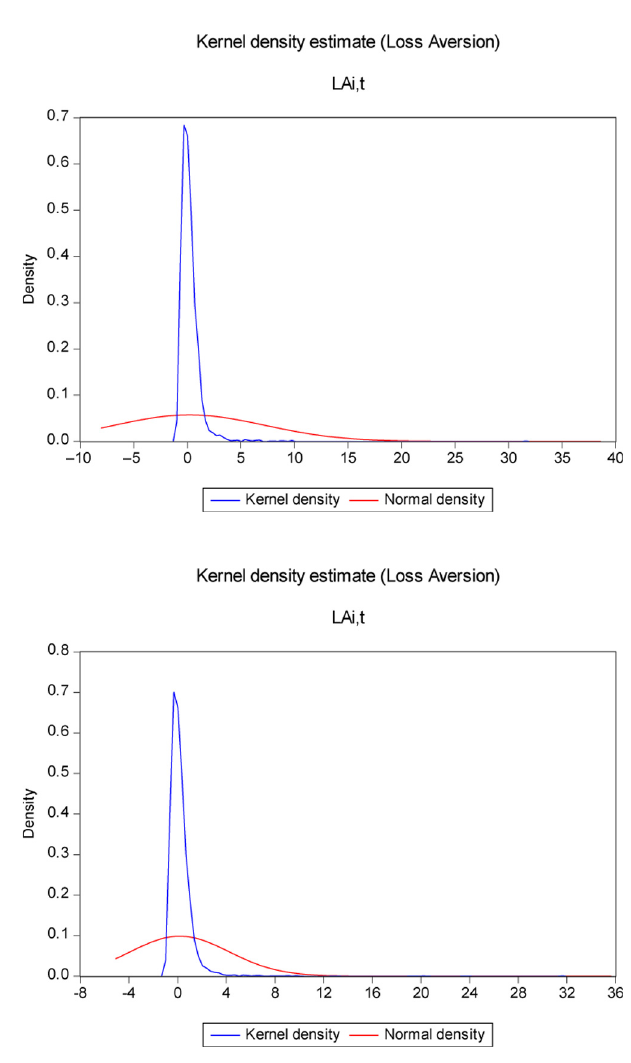
Figure 4. Non-normality of loss aversion (both